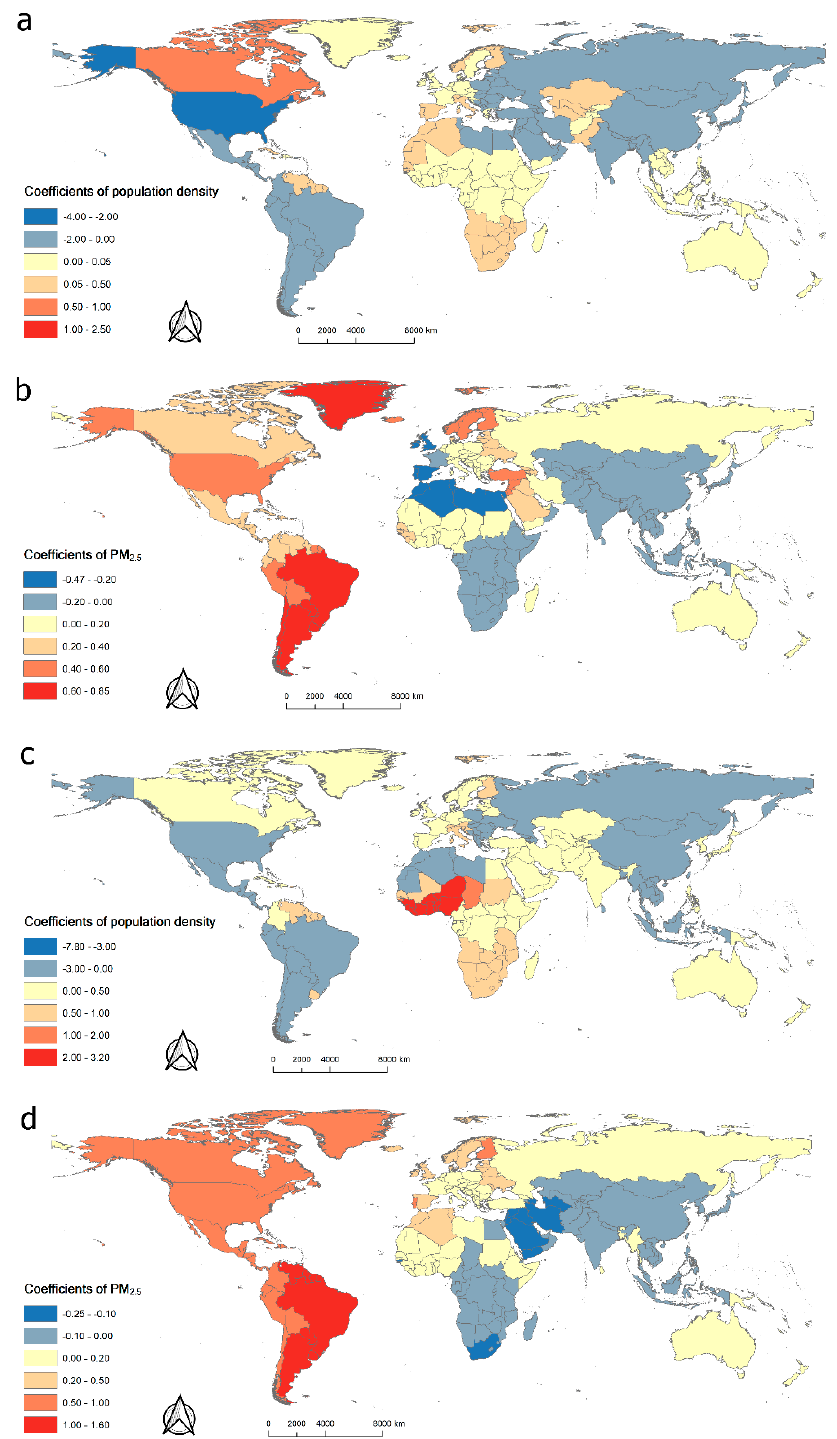
Figure 3. The spatial distribution of the impact of ( a ) population density on confirmed cases per million population; ( b ) PM 2.5 concentration on confirmed cases per million population; ( c ) popula- tion density on deaths per million population; ( d ) PM 2.5 concentration on deaths per million popu-